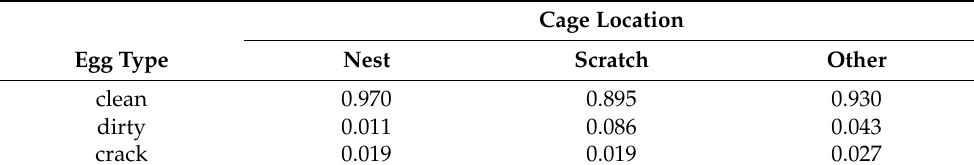
Table 5. Within Cage Location (opposite the nest box, scratch mat, all other areas), the Mean Proportion of Observed Eggs Laid by Egg Type (clean, dirty, crack).